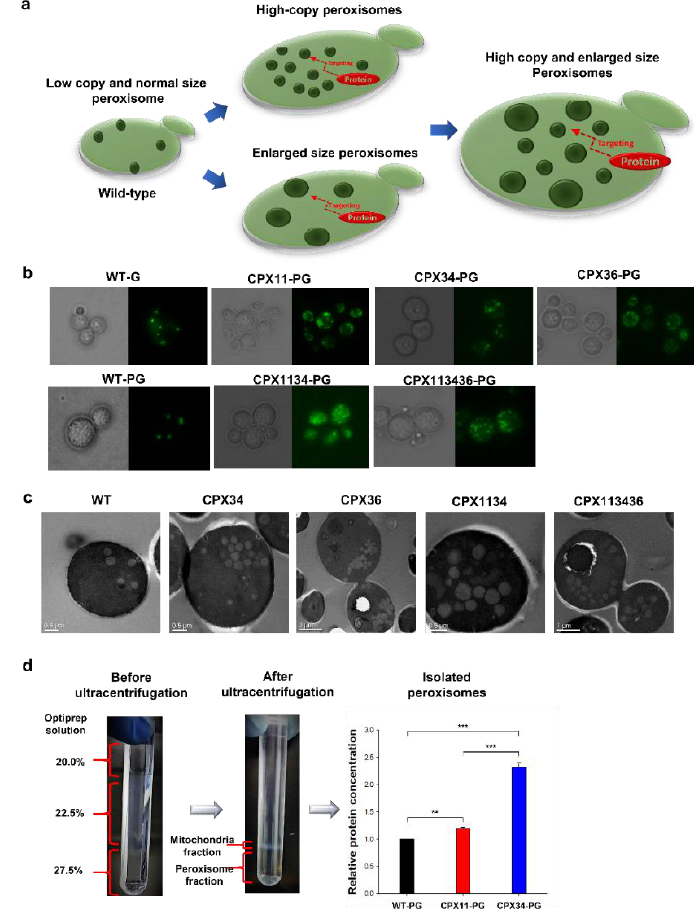
Figure 1. Engineering peroxisome biogenesis in Saccharomyces cerevisiae . ( a ) Schematic representation of the engineering of peroxisome biogenesis for increasing the copy number and size of peroxisomes in S.cerevisiae . ( b ) Fluorescence microscopy images of changes in the peroxisomes of peroxisome-engineered and wild-type (WT) strains. Genotype of the peroxisome-engineered strains are described in Table 1. Enhanced green fluorescent proteins targeted to peroxisomes were constructed by fusion with peroxisomal oxoacyl thiolase (PG) or peroxisome targeting signal 1 (PTS1) and then expressed in WT and peroxisome-engineered strains. ( c ) Transmission electron microscopy analysis of changes in the peroxisomes of peroxisome-engineered and WT strains. Scale bars: 0.5 µ m or 1.0 µ m. ( d ) Relative protein concentration of isolated peroxisomes from WT-PG, CPX11-PG, and CPX34-PG strains. Data are presented as the mean ± standard deviation of biological triplicates for protein quantification ( n = 3) and six replicates for counting peroxisome numbers ( n = 6) (** p < 0.01, *** p < 0.001). Unlike PEX34 overexpression and ATG36 deletion, PEX11 deletion (which formed the CPX11-PG strain) did not significantly influence the copy number of peroxisomes but generated enlarged and clustered peroxisomes. These changes in peroxisome biogenesis in